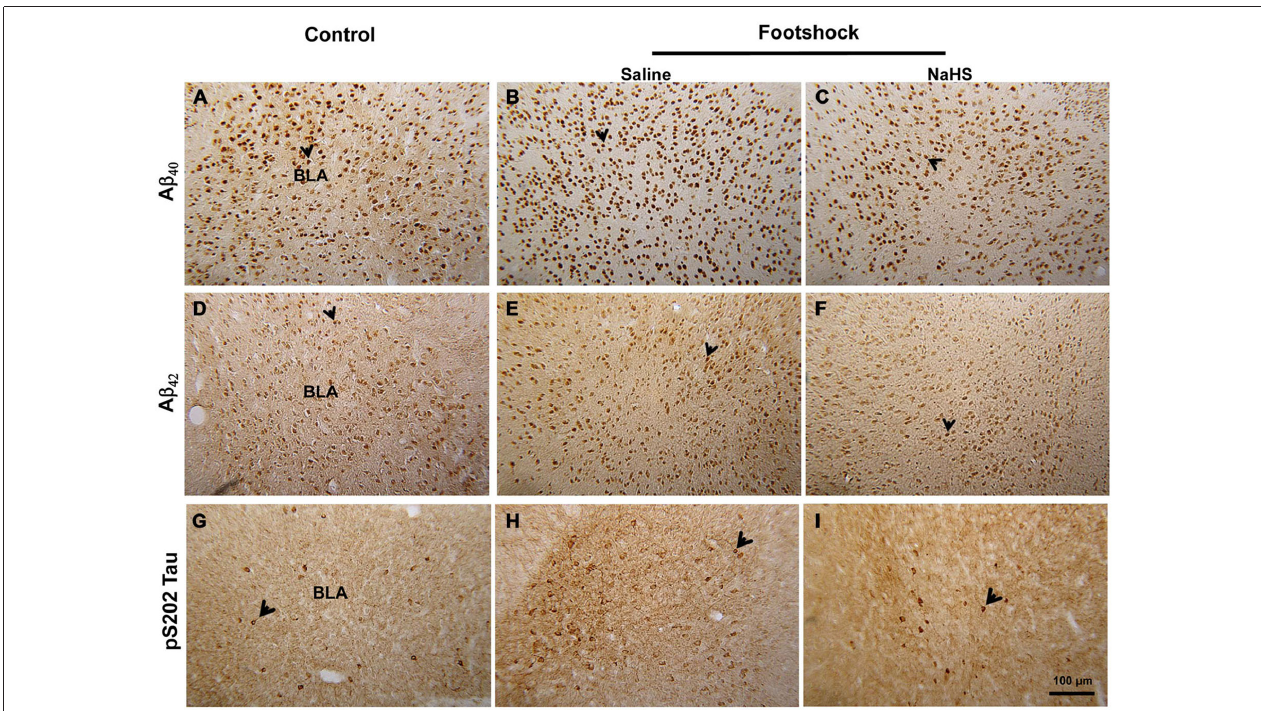
FIGURE 4 | The effect of NaHS on the level of amyloid deposition and pS202 Tau in footshock-stimulated 3 × Tg-AD mice. Representative immunostaining for A β